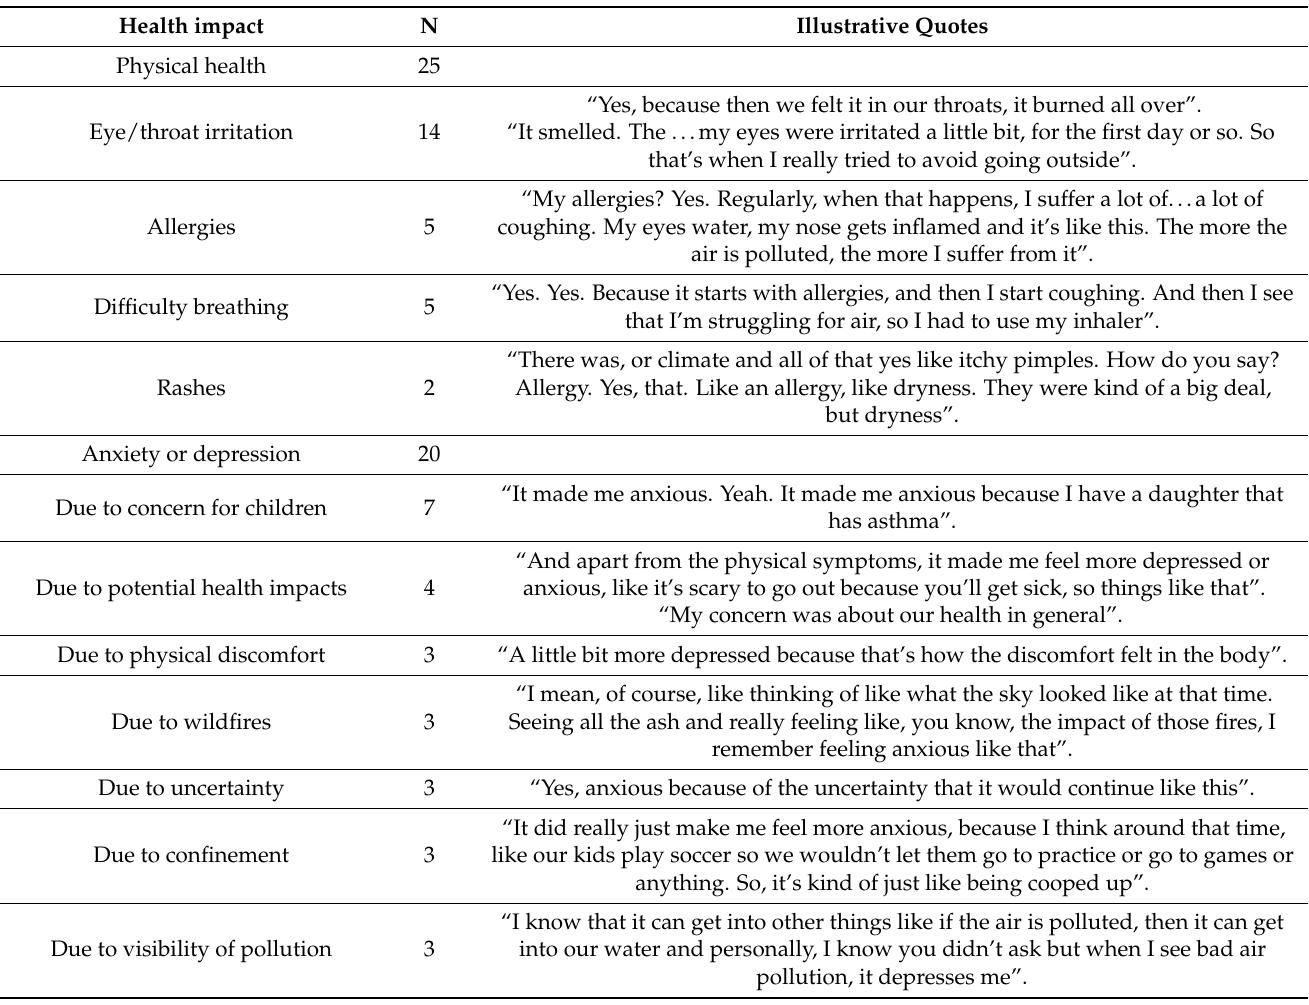
Table 5. Health impacts of air